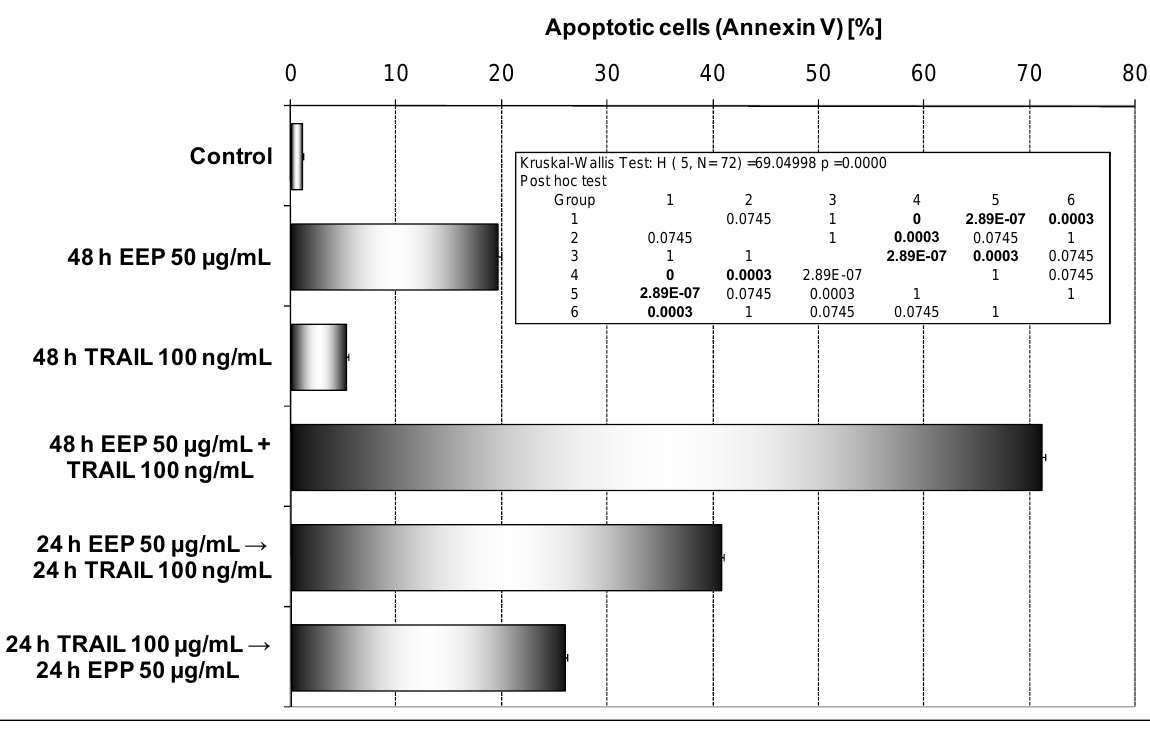
Figure 7. TRAIL induced apoptosis in combination with EEP, after and before exposure to EEP in HeLa cells. Detection of apoptotic cell death by annexin V-FITC staining using flow cytometry. HeLa cancer cells were: 1) treated with EEP in combination with TRAIL for 48 hours, 2) pretreated with EEP for 24 hours, followed by TRAIL for another 24 hours and 3) pretreated with TRAIL for 24 hours, followed by EEP for another 24